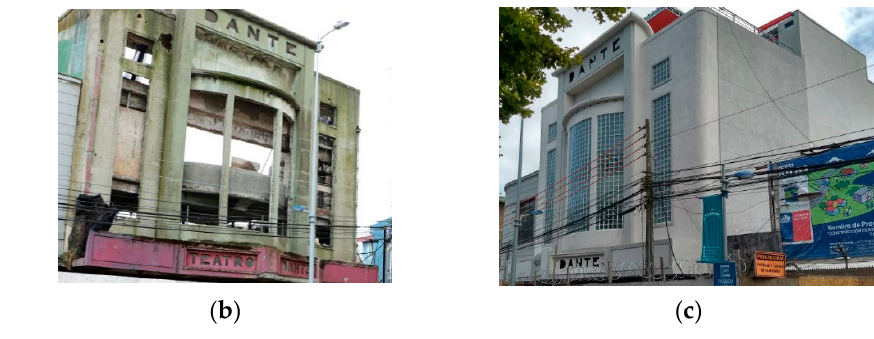
Figure 3. Dante Theater ( a ) Pre 2010; ( b ) Post 2010; ( c ) Post 2018.